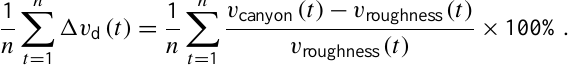
Figure 11. Time series of dry deposition velocity relative difference between the urban canopy and roughness-length models from Jan- uary 2011 to March 2011 in one chosen urban grid cell for three values of the building